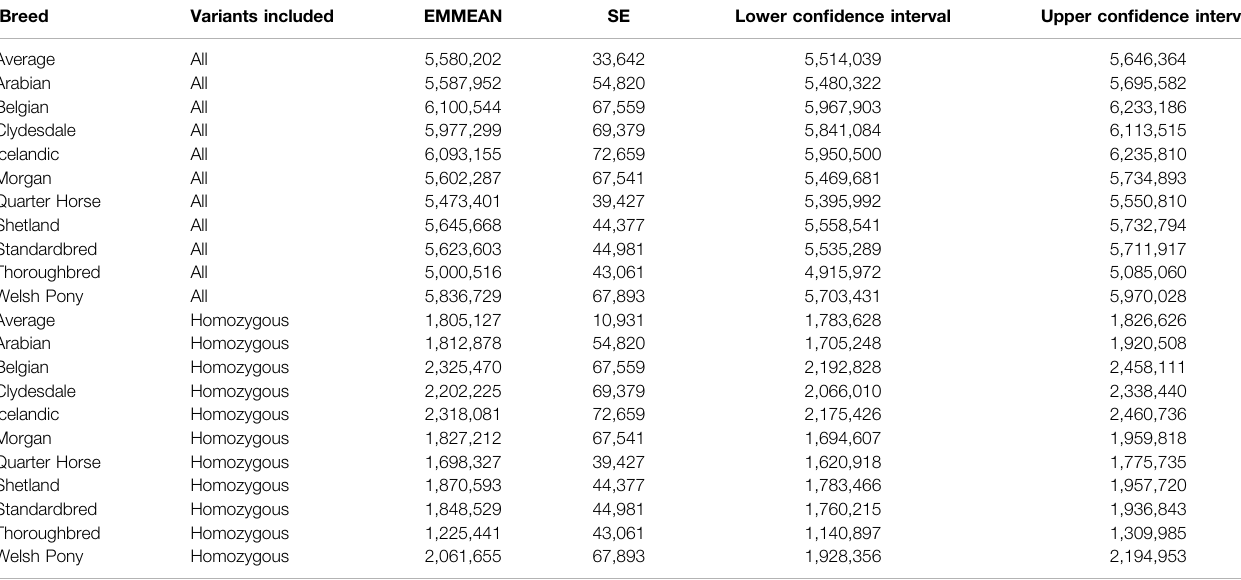
TABLE 4 | EMMEANs for number of variants within breeds accounting for DOC, standard error (SE), and 95% con fi dence intervals, with breed and DOC as predictor variables. Breed Variants included